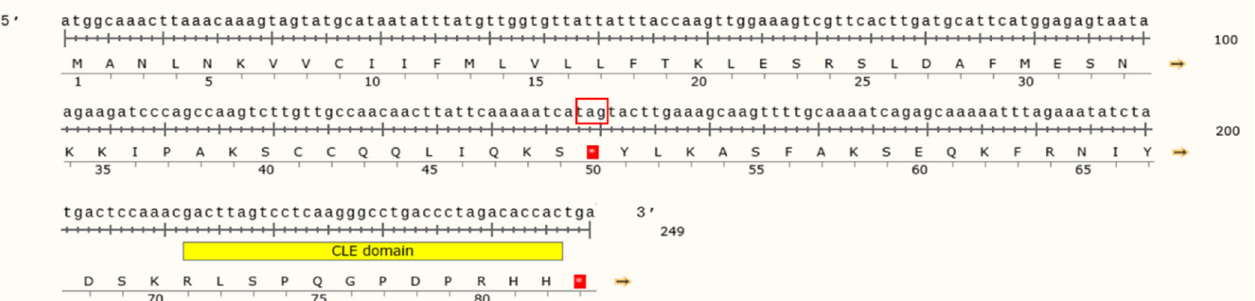
Figure 2. The sequence of the MtCLE34 gene in Jemalong A17. Stop codon is marked with a red box. CLE domain-coding region is marked with a yellow rectangle. CLE domain-coding region is marked with a yellow